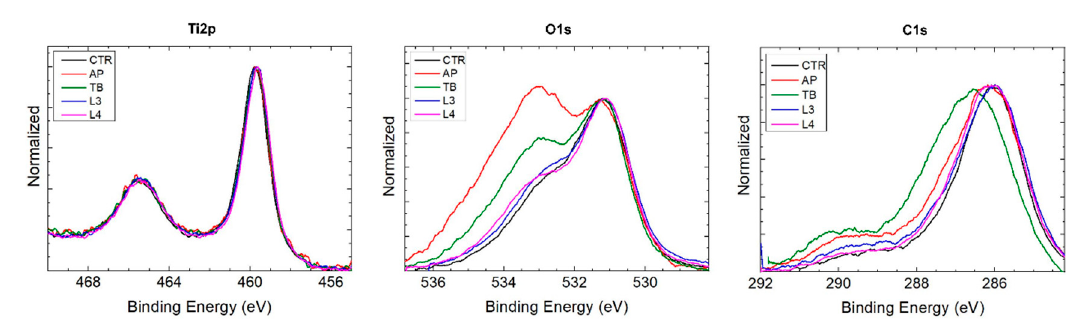
Figure 7. XPS (X-ray photoelectron spectroscopy) analysis of samples showing the spectra of Ti2p, O1s and C1s.